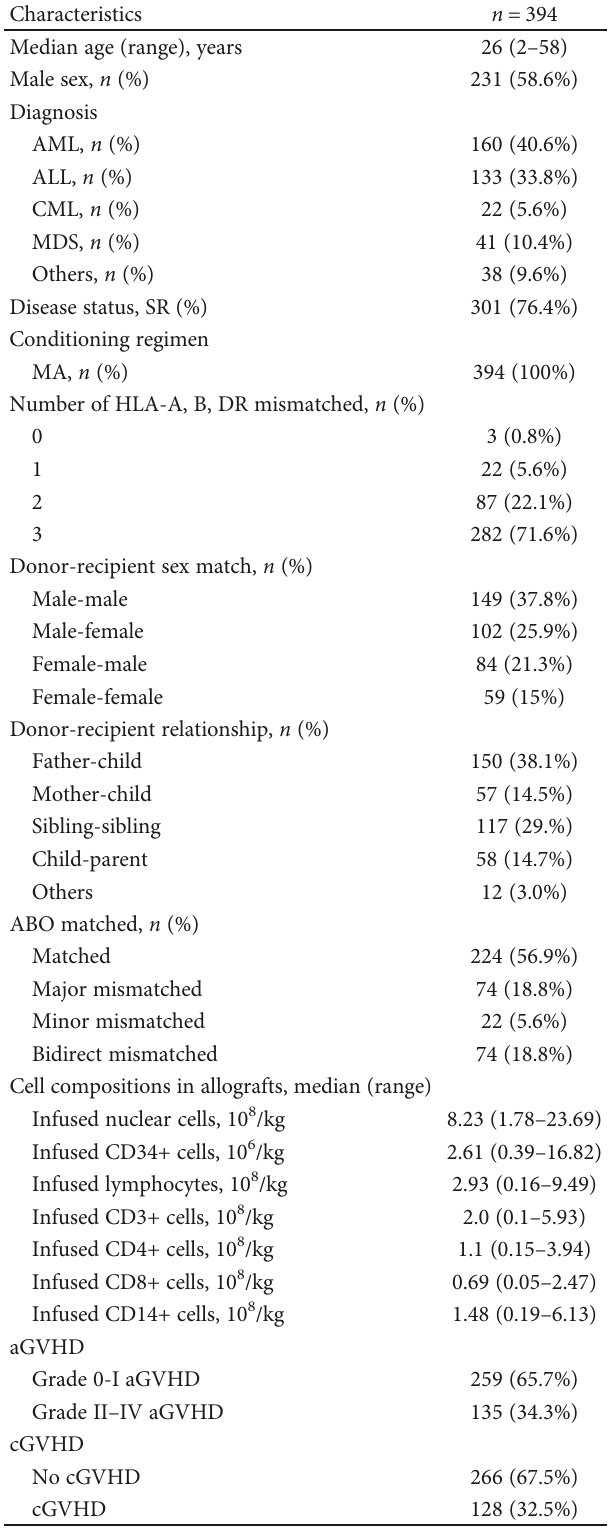
Table 1: Patient and donor